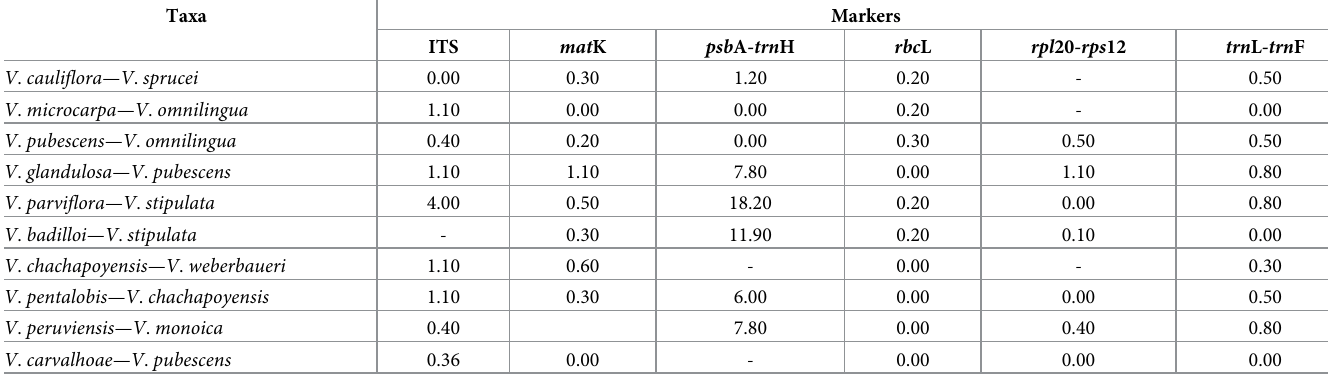
Table 3. Lowest genetic distance (p-distances) in percentage for species of Vasconcellea for six markers.